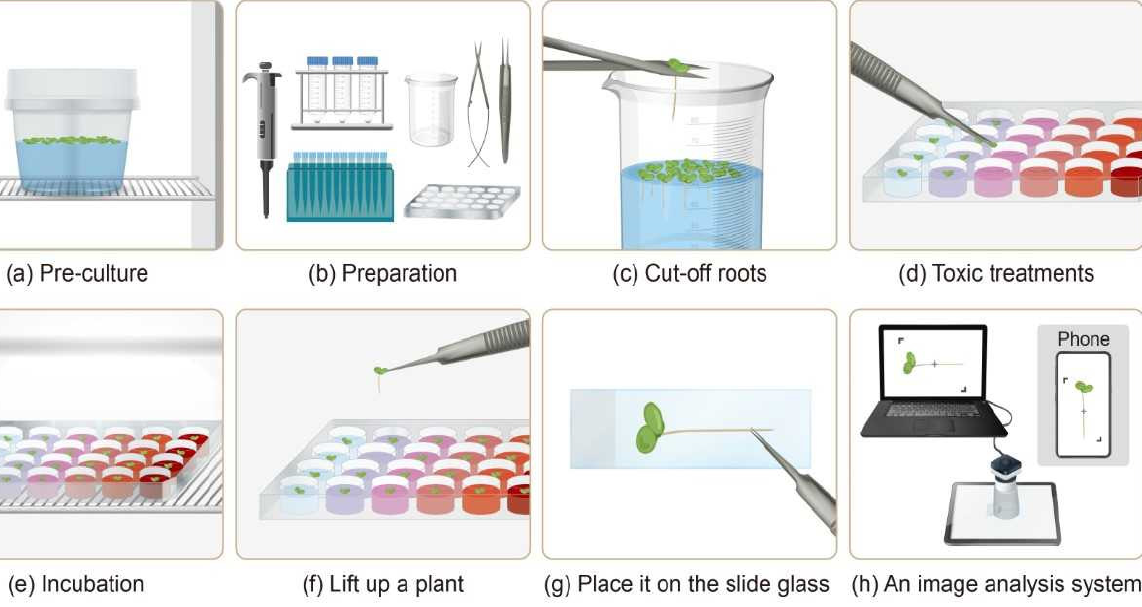
Figure 2. Details of Lemna root regrowth test protocol. ( a ) Preculture Lemna in a culture vessel. ( b ) Prepare experimental tools for toxicity tests. ( c ) Lift the plants with scissors and cut the root. ( d ) Place one plant without the root per well containing the test solution. ( e ) Cultivate under optimal environmental conditions. ( f ) After 72 h, lift the colony from the surface of the test solution with tweezers and ( g ) Place the colony on a slide glass with the roots aligned. ( h ) Measure the length of the longest roots using an image analyser or mobile phone.